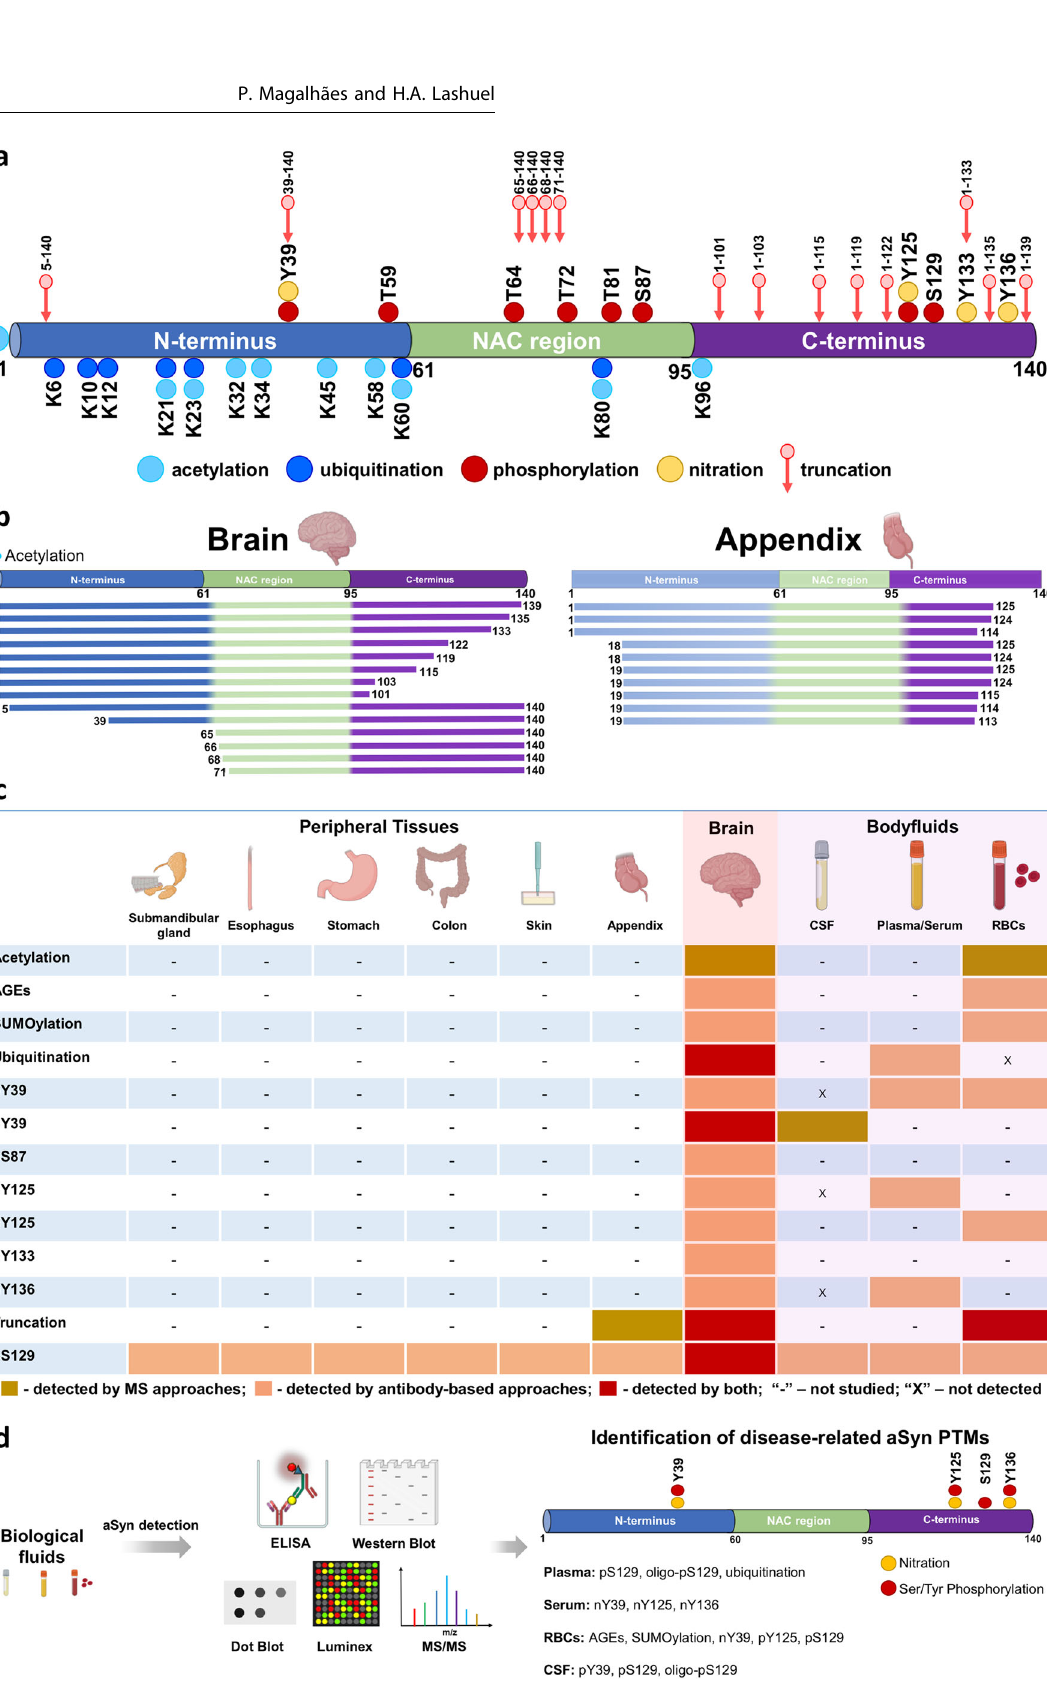
(CSF, plasma, serum, and RBCs); (2) present critical analyses of previous studies that have sought to explore the potential of total aSyn and aSyn PTMs as biomarkers to monitor disease progression or differentiate between PD patients and HC or between PD and